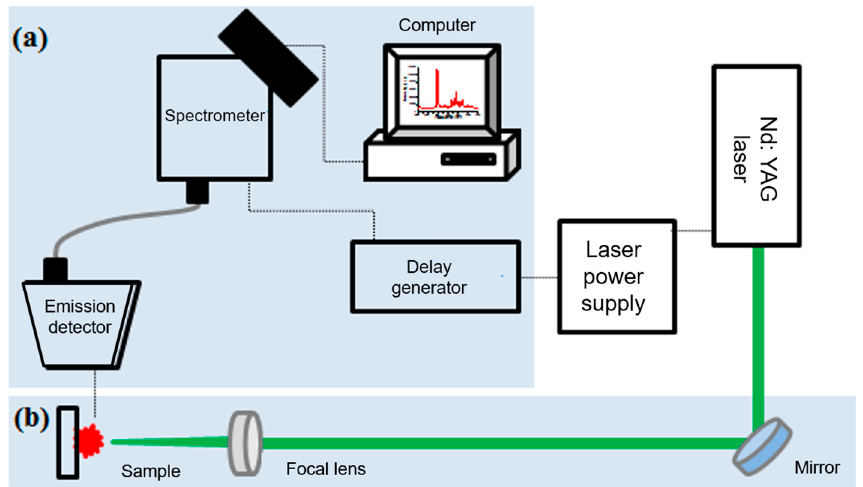
Figure 1. Schematic diagram of LIBS device; ( a ) spectrometer and ( b ) optics.